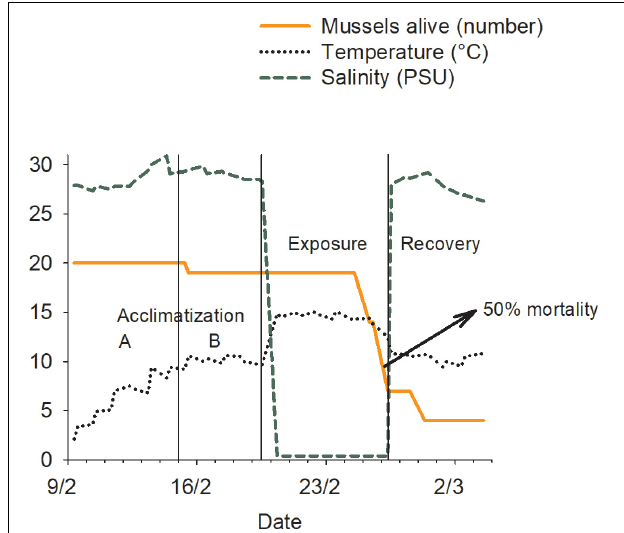
FIGURE 3 | Representation of an experimental trial involving blue mussels ( Mytilus edulis ) in a 10–15 treatment replicate, showing the variation in water temperature and salinity and the timing of the experimental phases. Units for the different variables are presented in parentheses in the figure